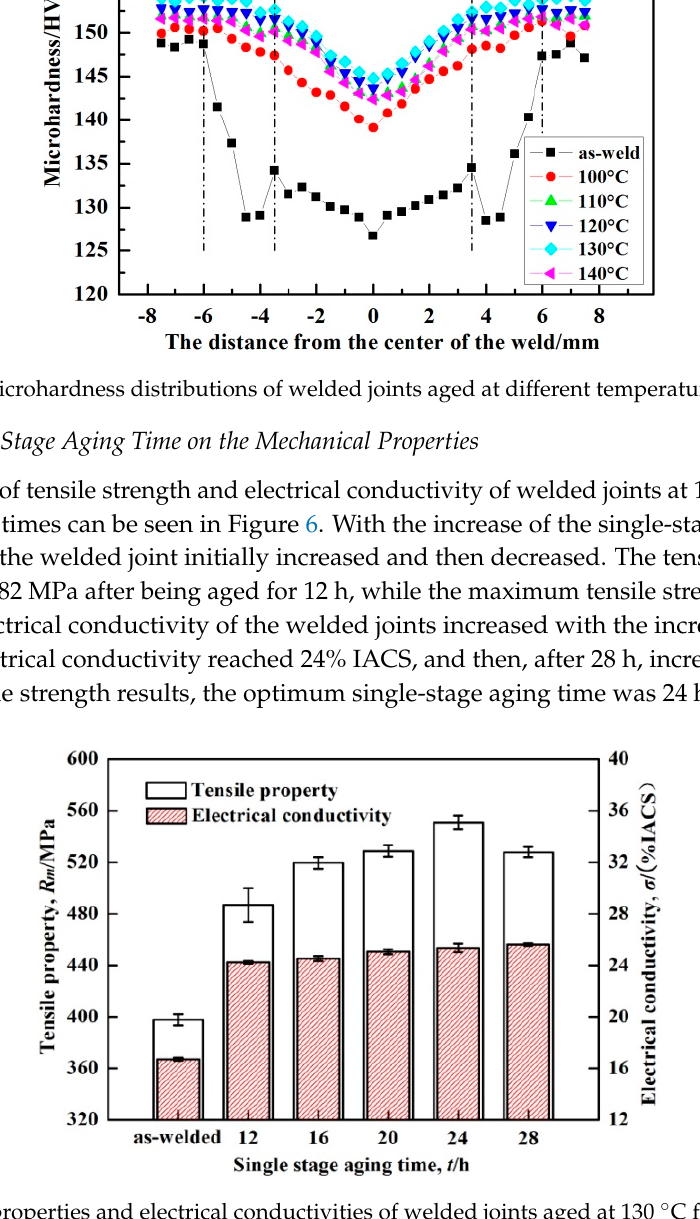
Figure 6. Tensile properties and electrical conductivities of welded joints aged at 130 °C for different times.